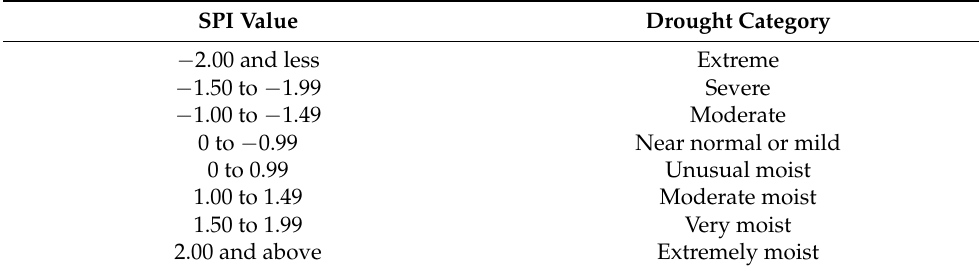
Table 1. SPI values and the corresponding categories of drought severity (McKee et al